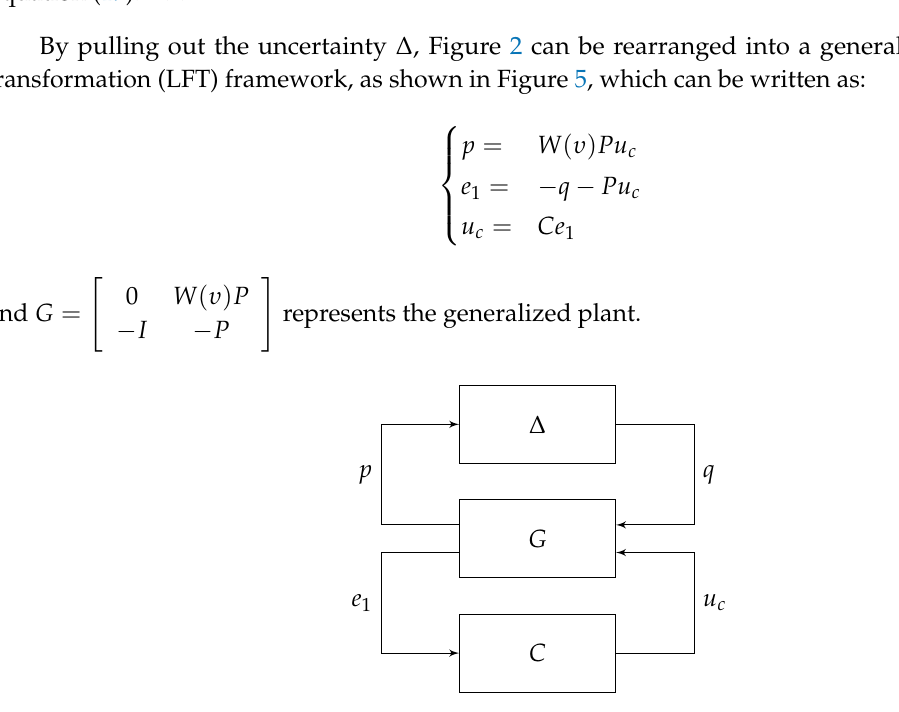
Figure 5. Equivalent closed-loop systems for Figure 2 in general LFT framework where G represents the generalized plant, and C is the internally stabilizing